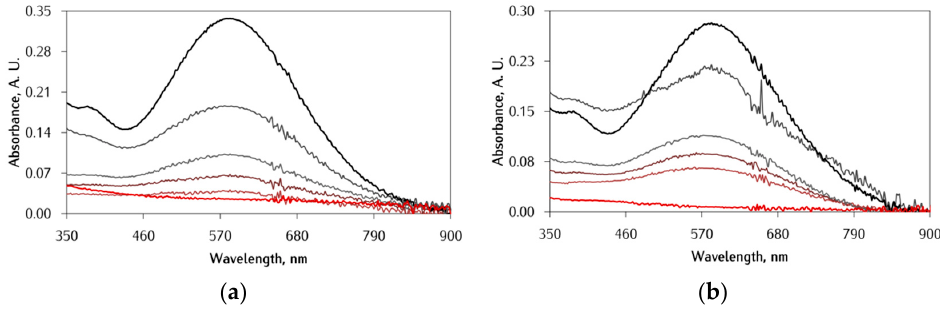
Figure 8. ( a ) UV-Vis spectra of DA oxidation at various times by Fe II (DA:Fe 2:1) in 10 mM Mops bu ff er pH 7.0 and 37 °C; progression of time is rendered as color hue transition from black (0